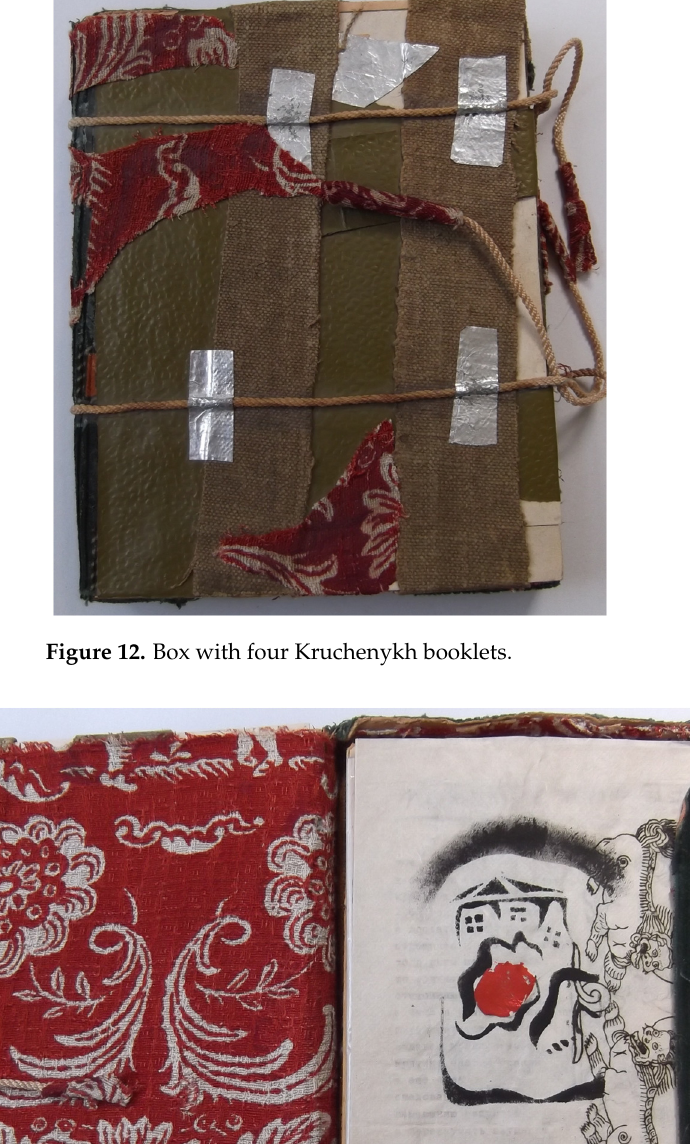
Figure 11. Cover of ‘Igra v adu’.